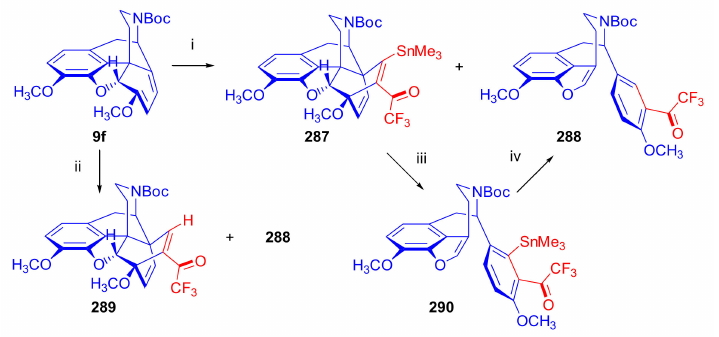
Figure 78. Reaction of N 17 - tert -butoxycarbonyl-northebaine with acetylenic dienophiles. Reagents and conditions : (i): 4-trimethylstannyl-1-trifluoroacetylacetylene, chlorobenzene, 65–75 ◦ C, 4 h, or THF, reflux, 6.5 h; (ii): trifluoroacetylacetylene, THF, 5–20 ◦ C, a few